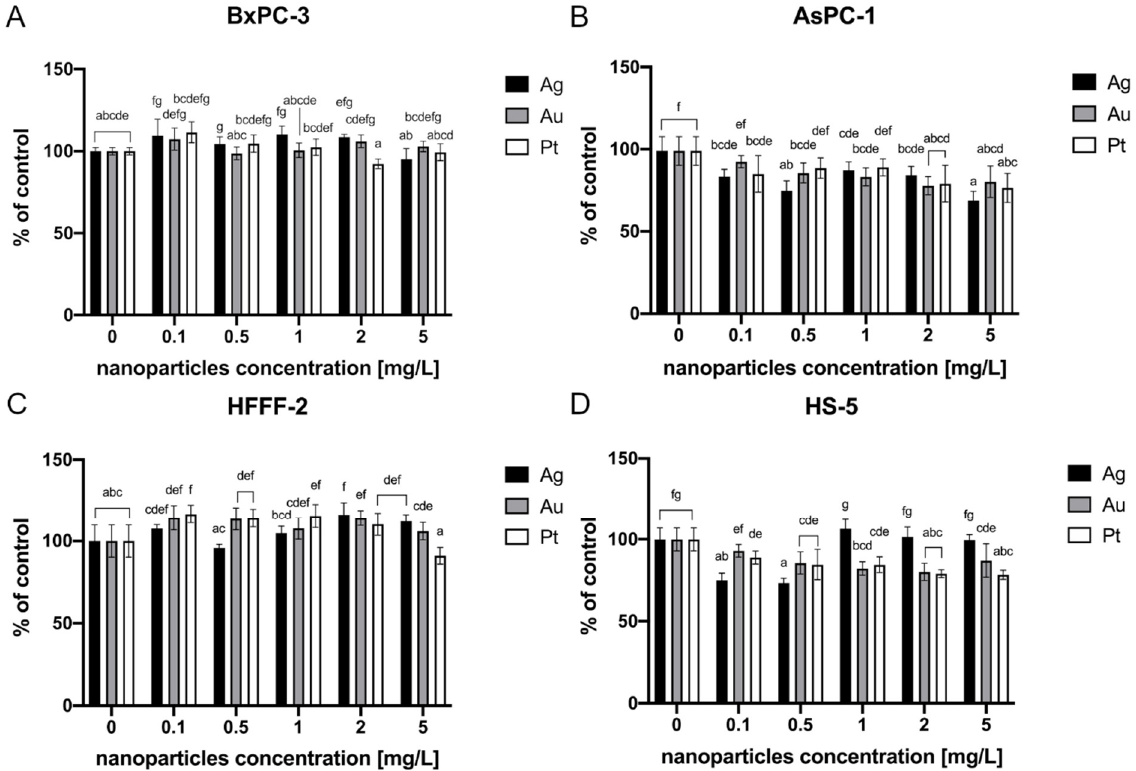
Figure 4. Viability of the cells after a 24-h incubation period with metallic NPs as determined by an MTT assay. The results are presented as a percentage of the control (mean with standard deviation). Different letters above the columns indicate statistically significant differences between the groups ( p ≤ 0.05). Capital letters refers to different cell lines: ( A ) BxPC-3; ( B ) AsPC-1; ( C ) HFFF-2; and ( D ) HS-5.